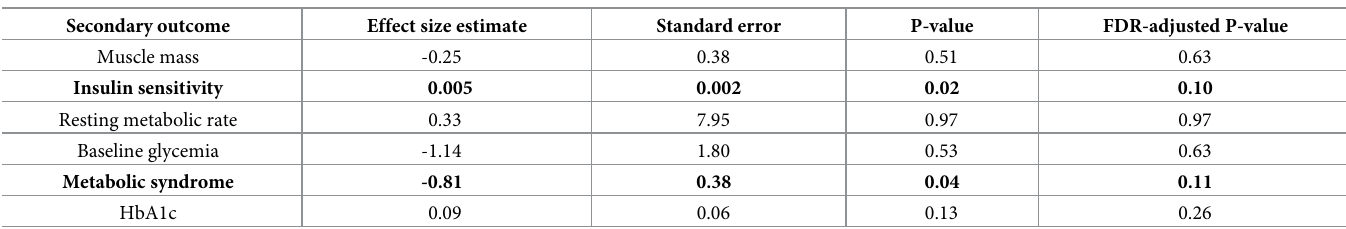
Table 2. Associations between secondary outcomes and